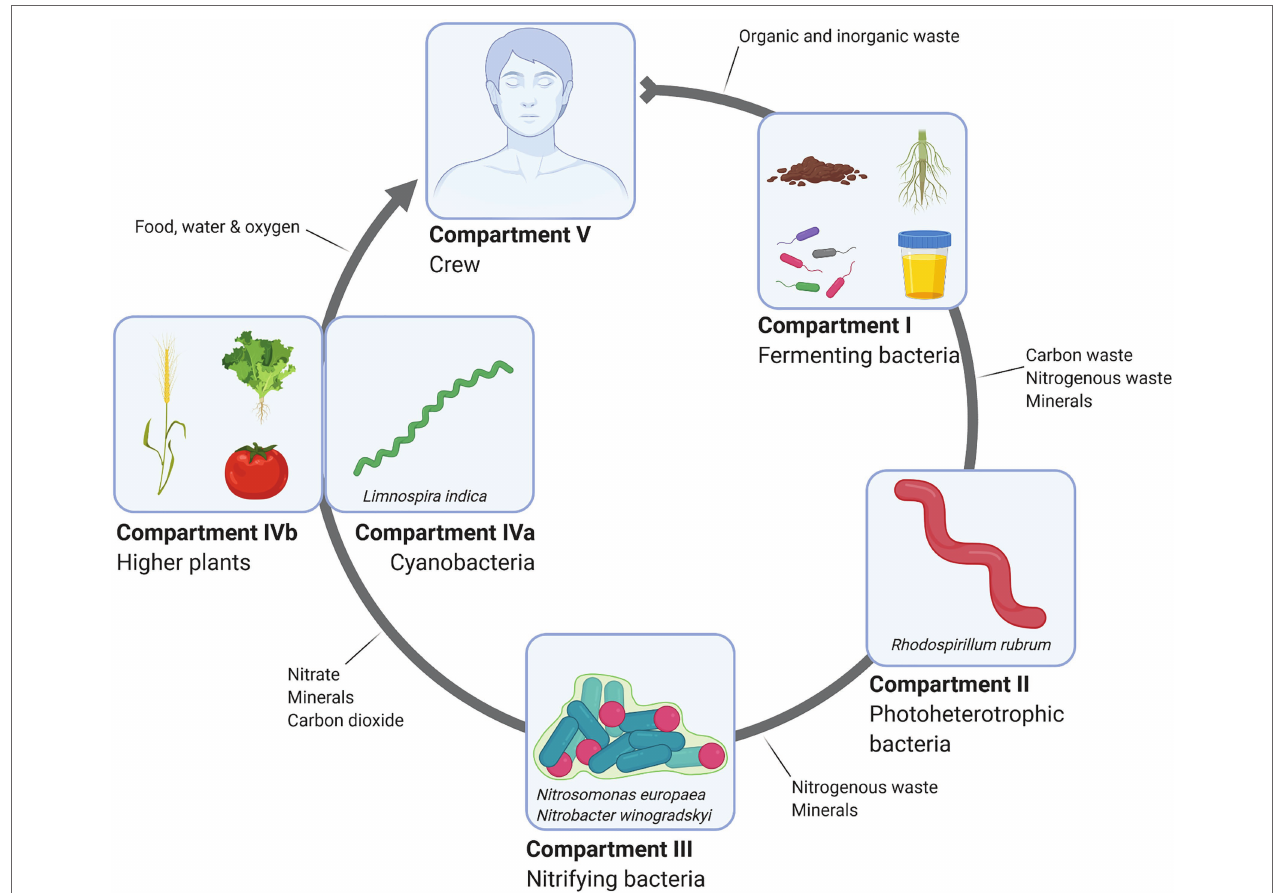
FIGURE 3 | Schematic overview of the MELiSSA